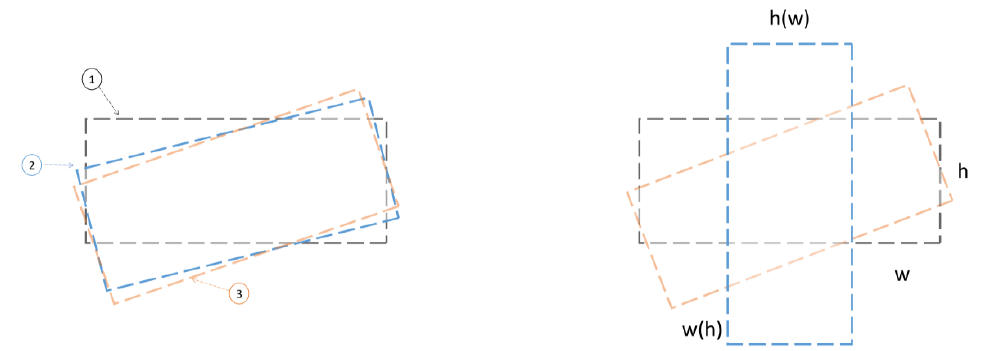
Figure 8. PoA and EoE problem